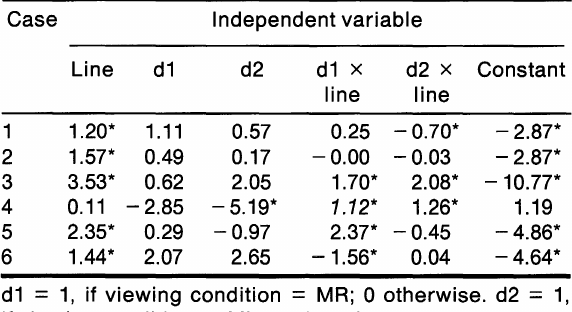
TABLE II. Multiple regression analysis: